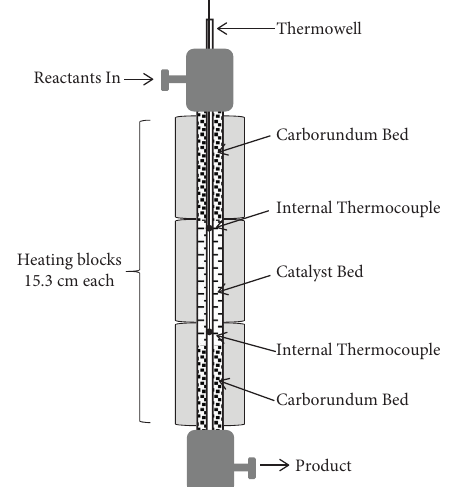
Figure 2: Schematic illustration of the reactor and catalyst